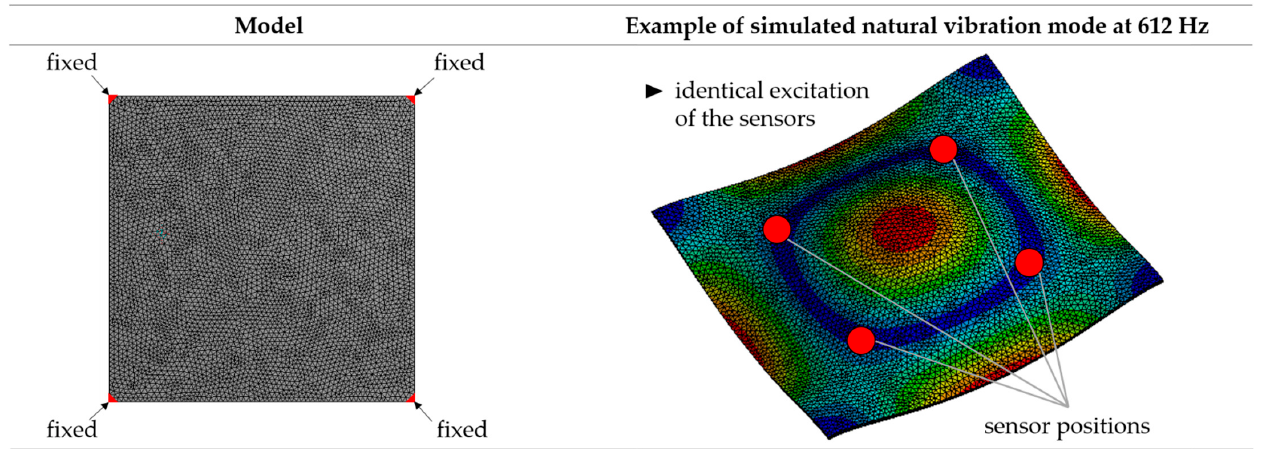
Figure 6. Simulation model for modal analysis of the clamped sheet ( left ) and example of calculated natural vibration mode ( right ).